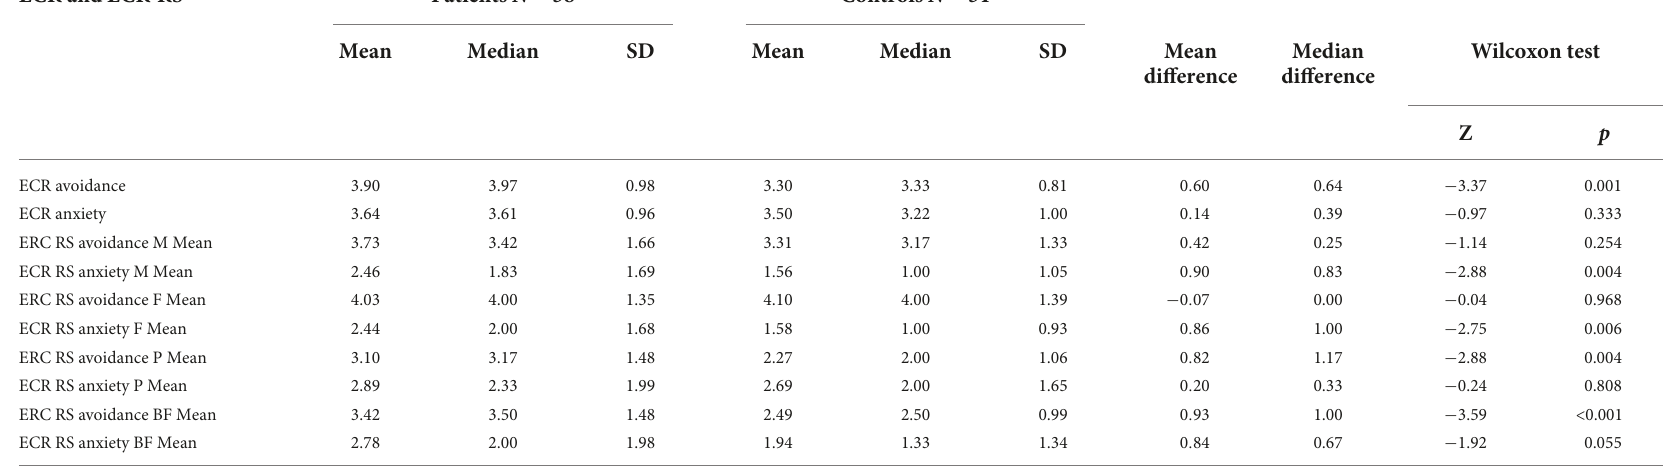
TABLE 5 Comparison of the attachment structure between patients and healthy volunteers. ECR and ECR-RS